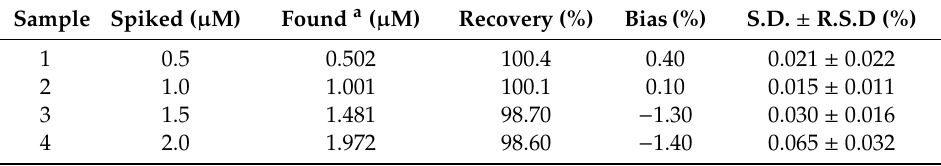
Table 3. The application of MWCNT / Cellulose for determination of AMT in urine samples. Sample Spiked ( µ